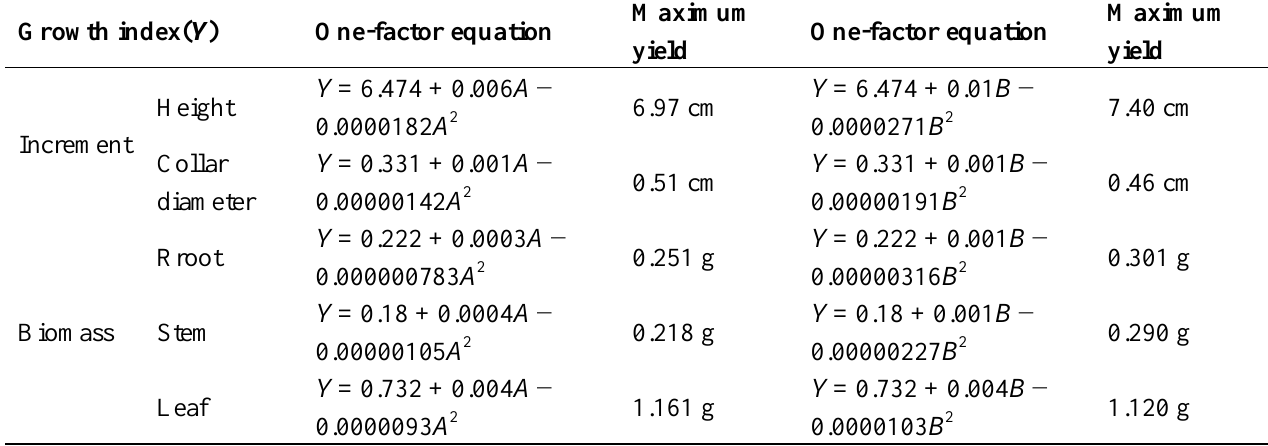
Maximum Maximum One-factor equation yield